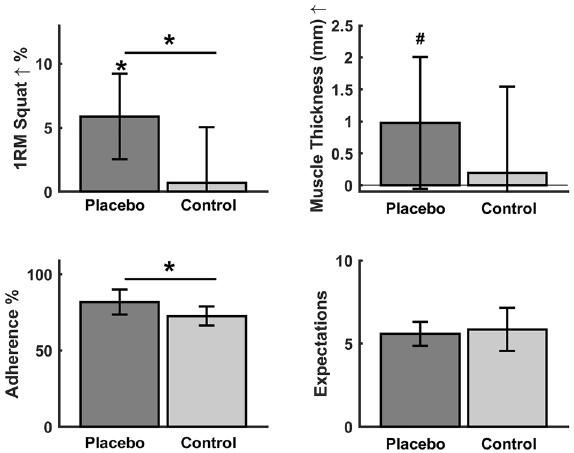
Figure 2. Illustrating percent change in 1RM ( One repetition maximum ) squat, change in muscle thickness (mm: millimeters), Adherence between groups measured as percentage of completed scheduled training sessions as well as median expectation (SETS: Stanford Expectations of Treatment Scale) of the placebo and control group. *p < 0.05 # p < 0.10, where the horizontal line represent group changes. Error bars represent 95% confidence intervals (except for SETS which illustrate median with upper and lower quartiles).